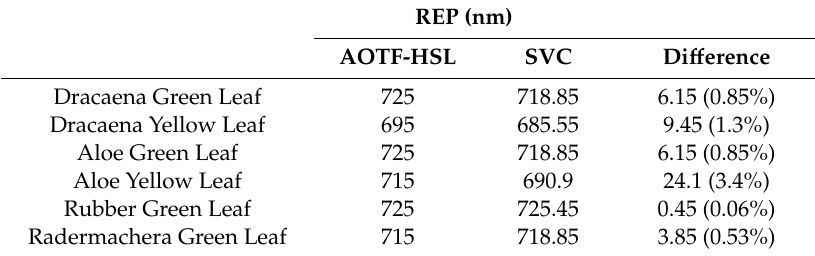
Table 2. “Red edge” position measuring results based on FRS. Table 3. “Red edge” slope measuring results.